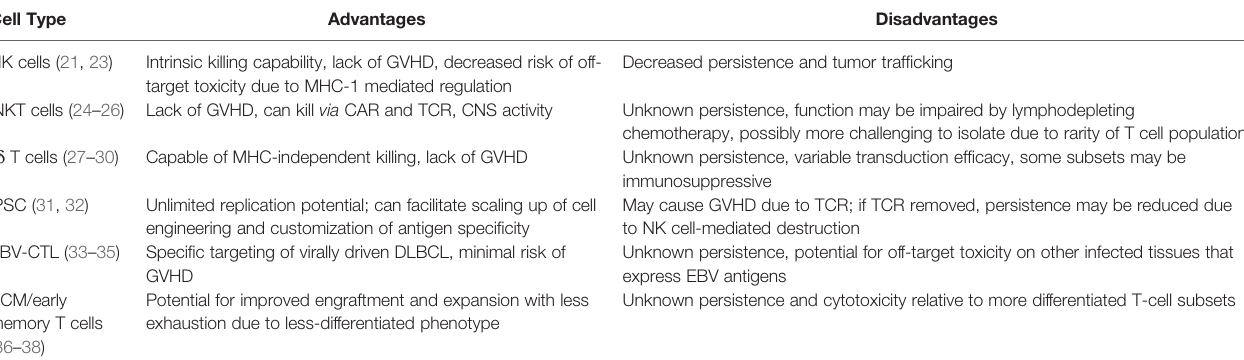
TABLE 2 | Advantages and Disadvantages of Potential Cellular Sources for Allogeneic